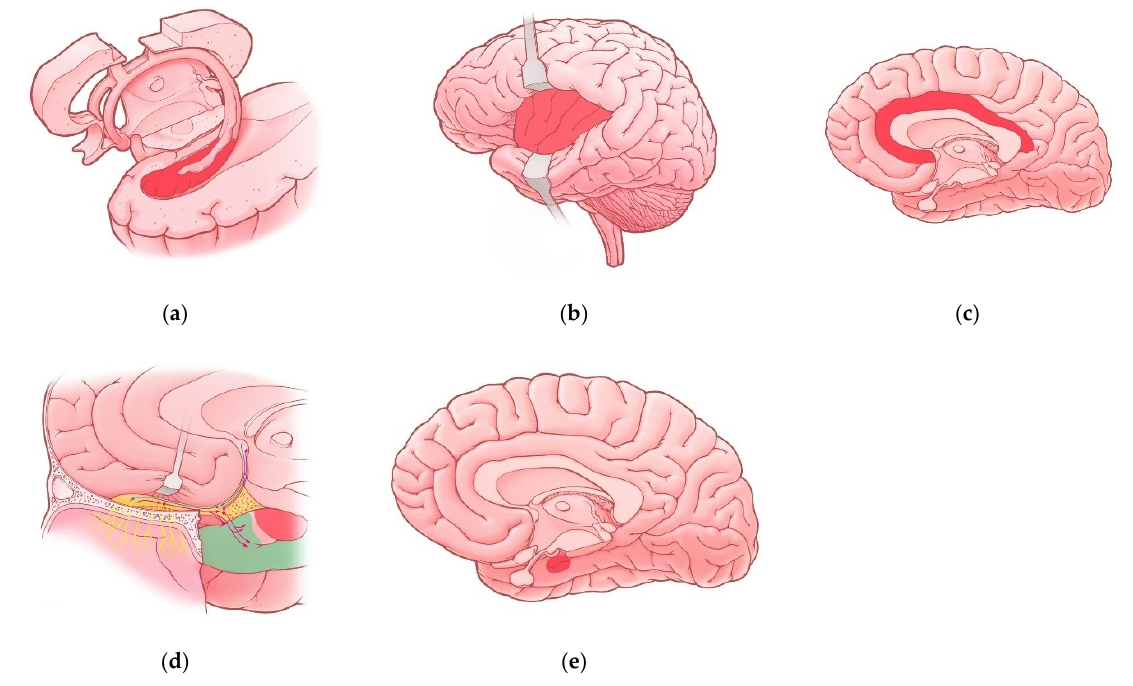
Figure 1. Regions of the limbic system affected in COVID-19 patients: ( a ) Hippocampus; ( b ) insula; ( c ) cingulate gyrus; ( d ) olfactory cortex—red-colored region represents uncus and green-colored region represents parahippocampal gyrus, red and blue lines represent olfactory pathways; ( e ) Amygdala (projection).